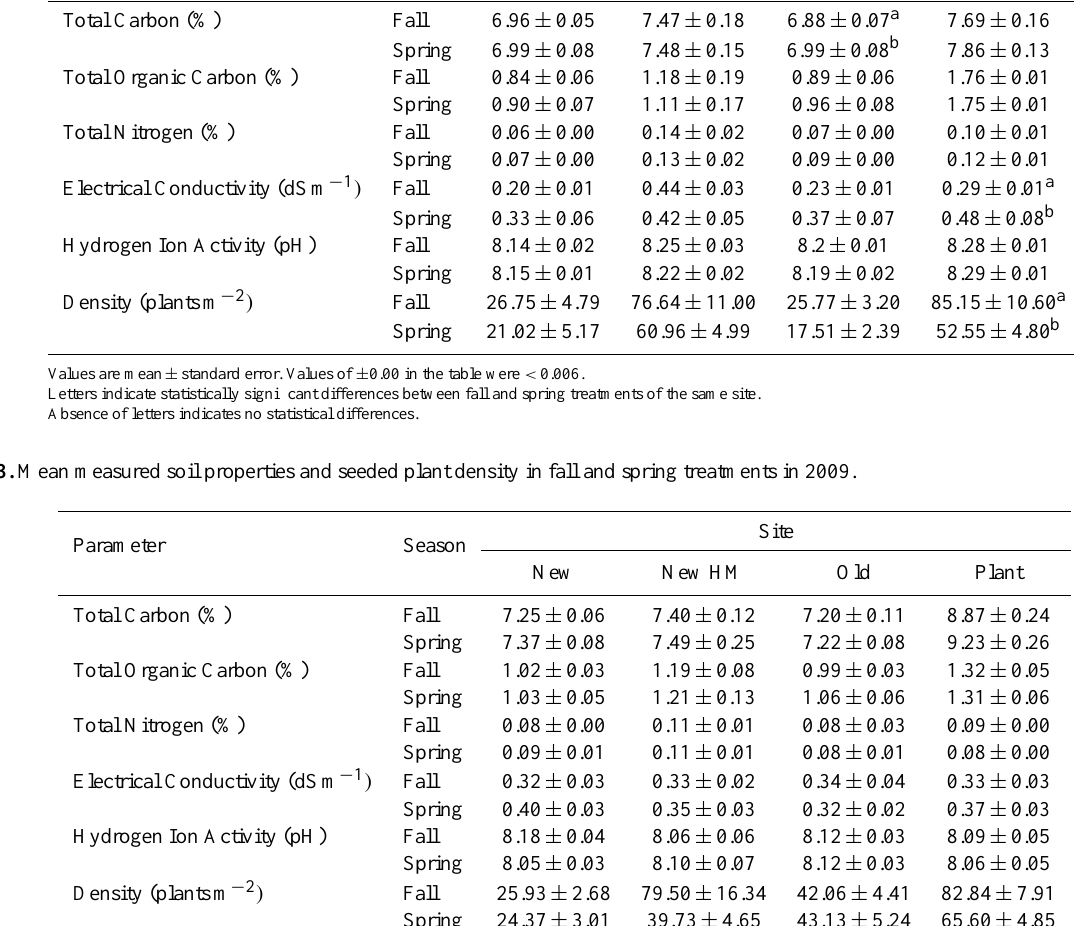
Table 2. Mean measured soil properties and seeded plant density in fall and spring treatments in 2008. Parameter